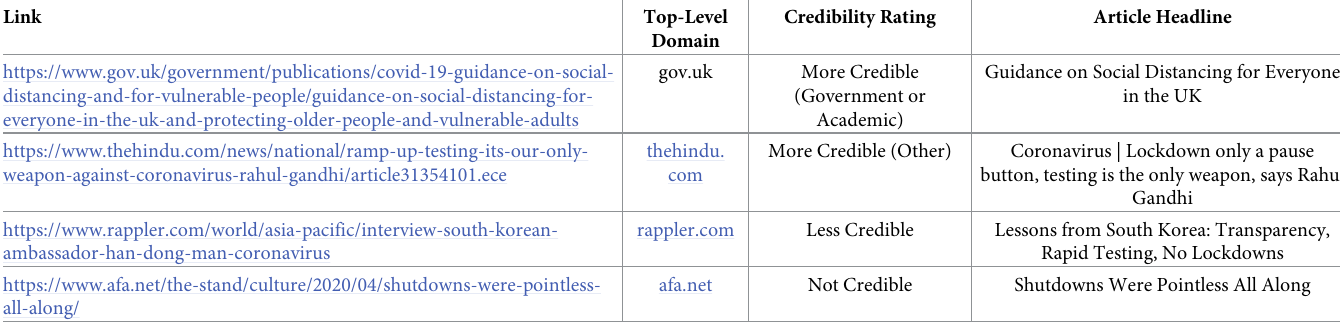
Table 2. Examples for each credibility category. Link Top-Level